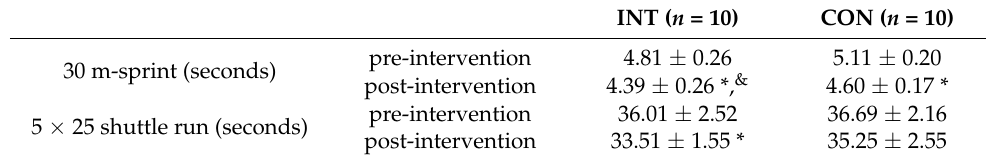
Table 3. Changes in running ability.